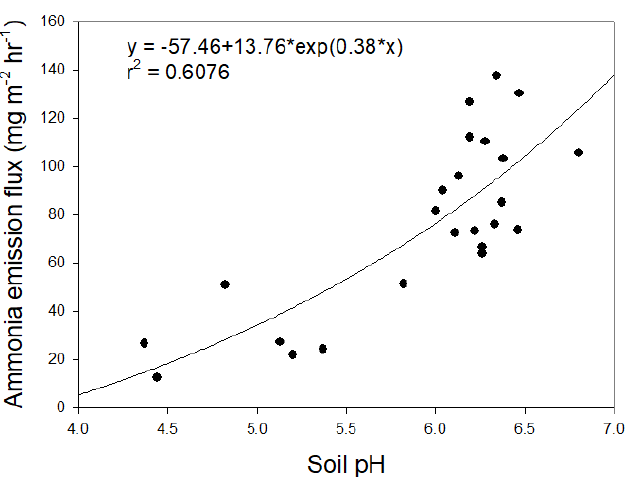
Figure 2. Changes in ammonia emission rate according to soil pH after liquid fertilizer application using the dynamic chamber-capture system ( n = 24).